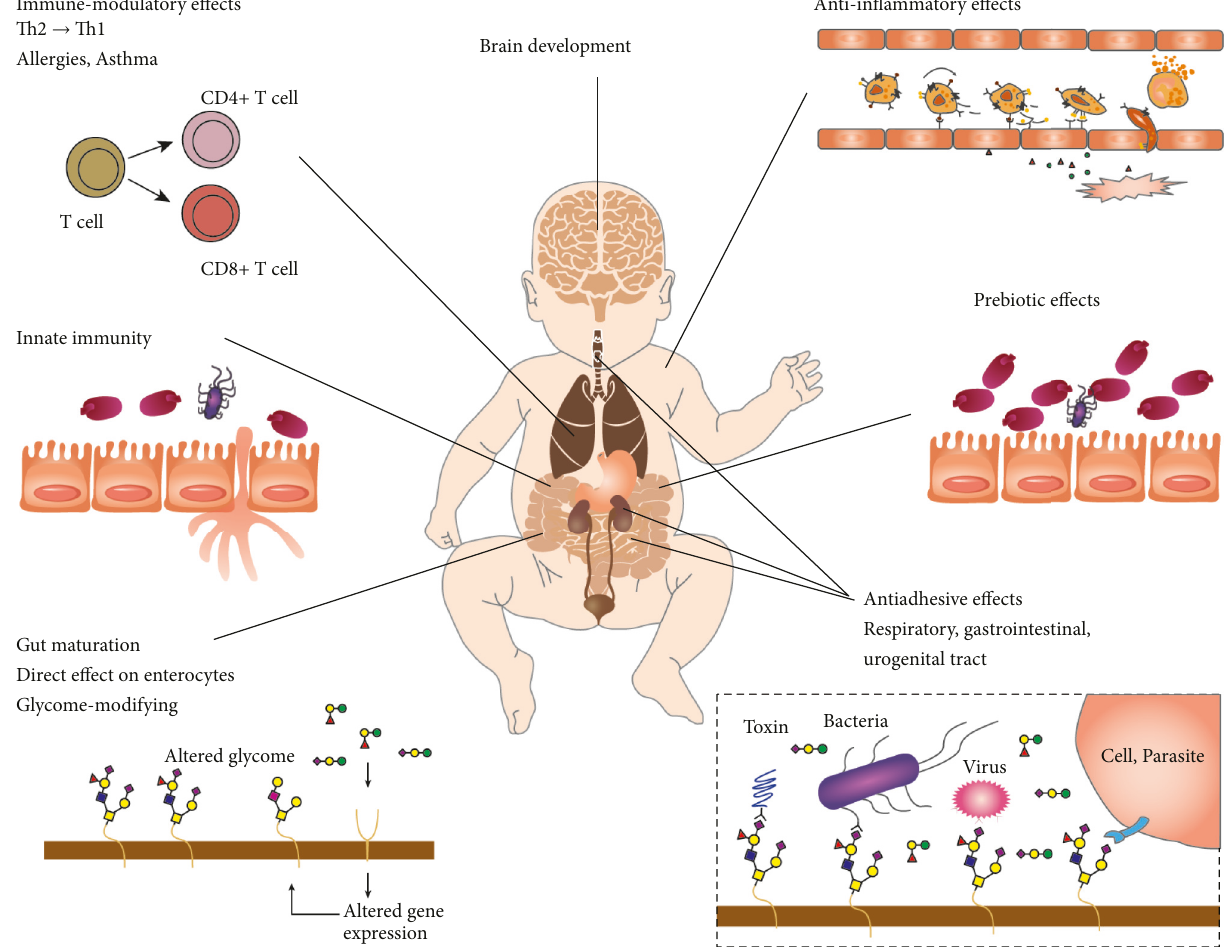
Figure2:Potentialbenefitsforbreast-fedneonates.HMOsmayserveasprebiotics,immune-modulators,andsignallingmoleculestoenhance the gut immunity of